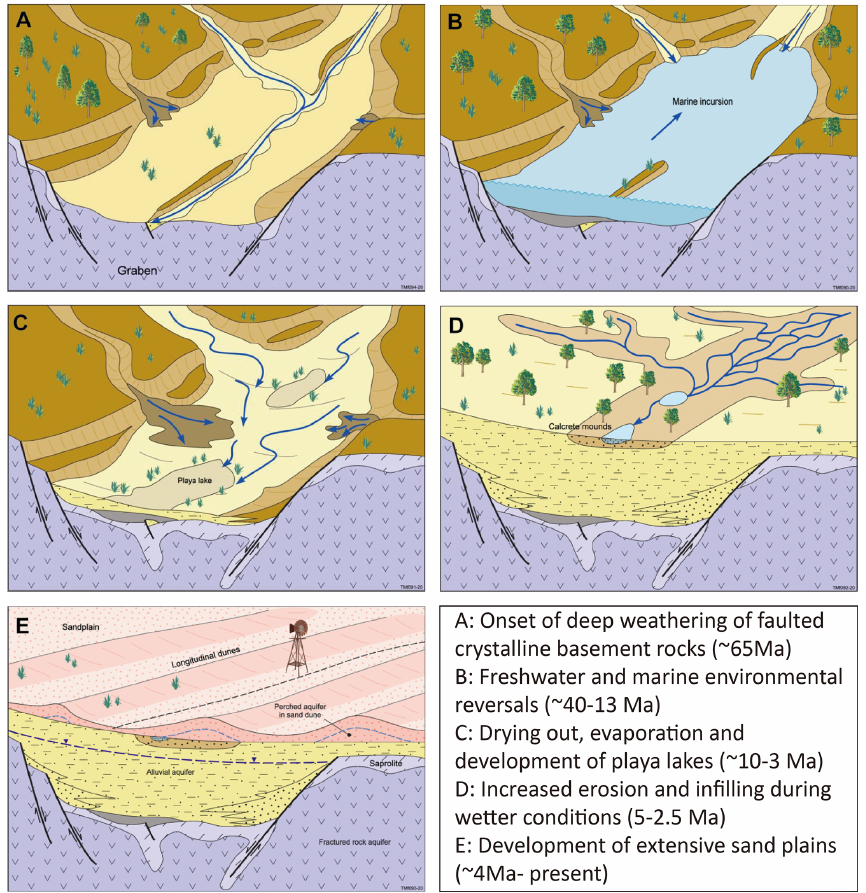
Figure 1. Conceptualized genesis of the paleovalley landscape in the Musgrave Province in South Australia (after Krapf et al., 2019; Munday et al.,